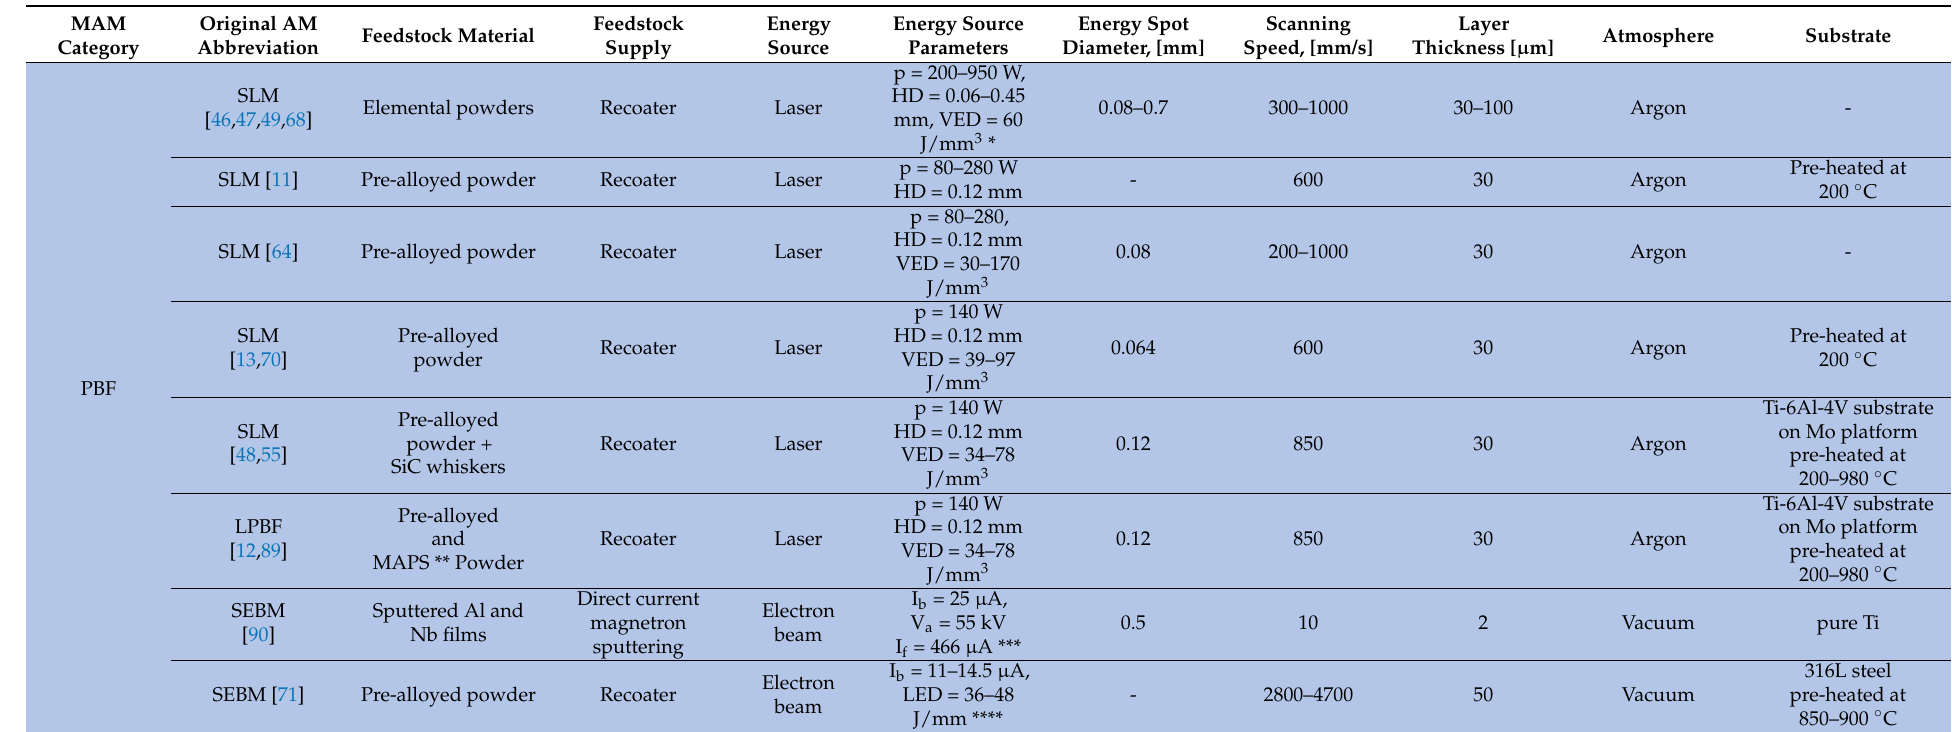
Table 4. Process parameters of MAM utilized for Ti 2 AlNb-based